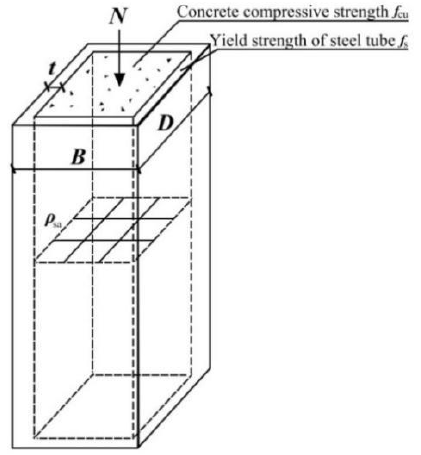
Figure 2. Geometrical factors of SCFT stub columns.